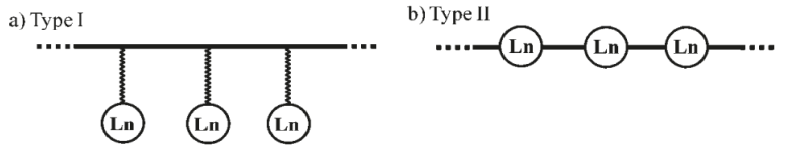
Figure 18. Two different strategies for the introduction of lanthanide binding sites into molecular multifunctional probes. The chelating units are (a) connected to the periphery (type I) or (b) in series through bridging ligands (type II). Reproduced from [215] and [216], with permission from ACS, 2008, and RCS, 2011, respectively.